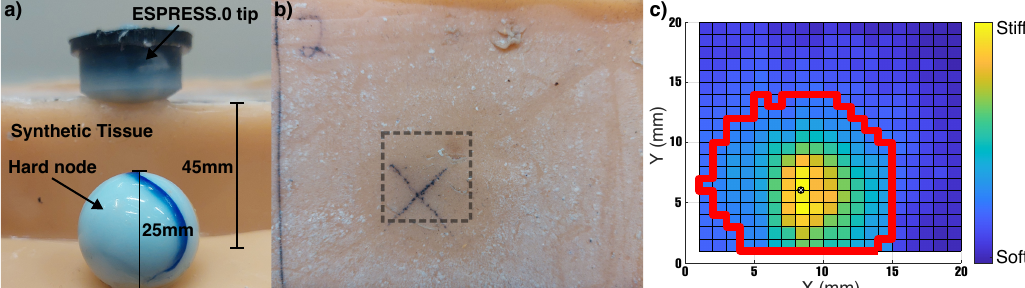
Figure 12. Palpation of synthetic tissue sample with embedded hard node. ( a ) Illustration of depth and size of components involved and synthetic tissue. ( b ) Top view of the sampled area on the synthetic silicone tissue sample. ( c ) The top view of tactile output at 15mm depth shows the centroid of the stimulus (white cross in black circle) and its inferred shape (red